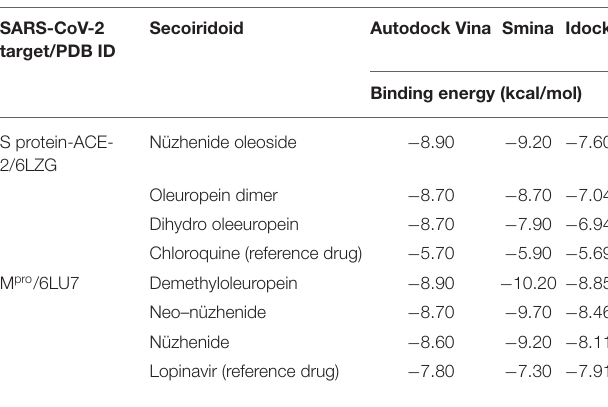
TABLE 1 | Binding energies during precise docking of the three top-ranked olive secoiridoids to SARS-CoV-2